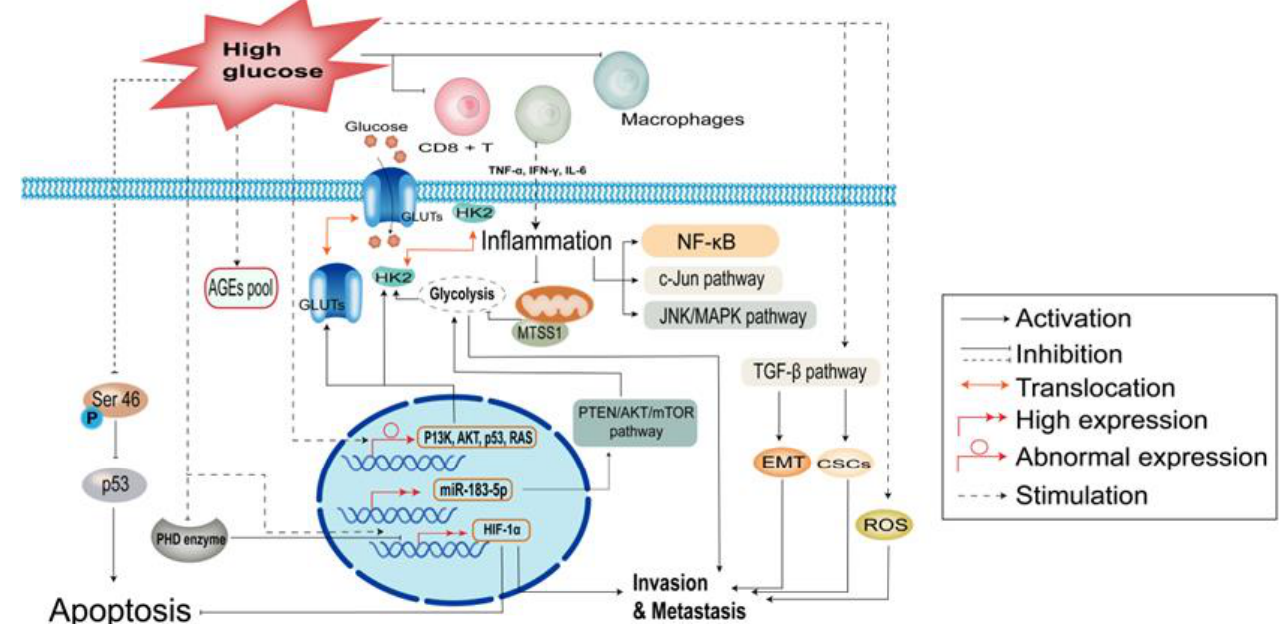
Figure 1. Mechanisms by which abnormal glucose metabolism contributes to malignant tumor development.